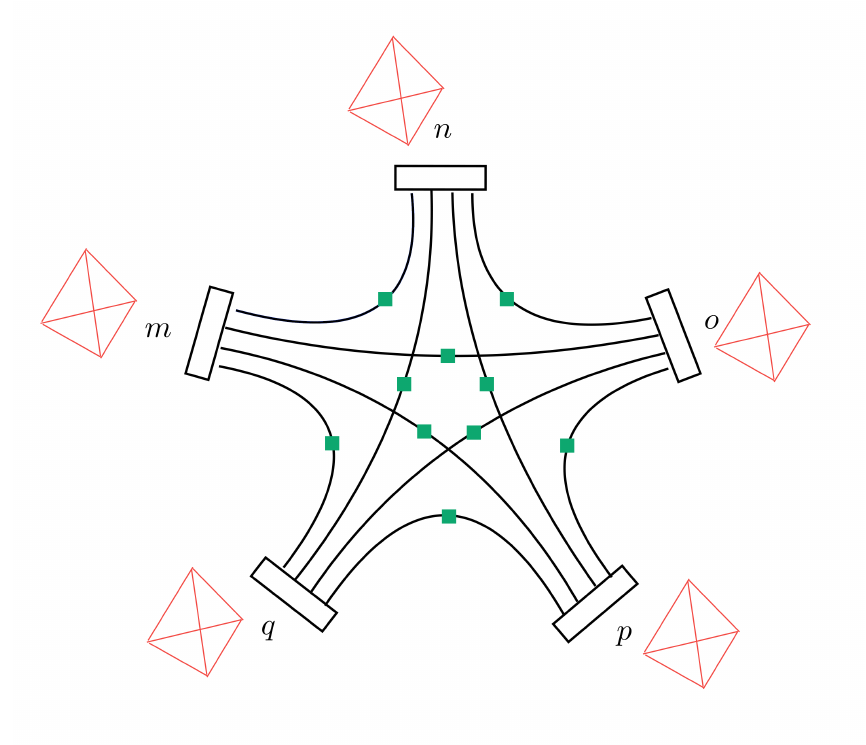
Figure 1. Bisected boundary graph of a 4-simplex, as a result of non-local pair-wise gluing of half-links. Each full link is bounded by two 4-valent nodes (denoted here by m , n ,...), and bisected by one bivalent node (shown here in